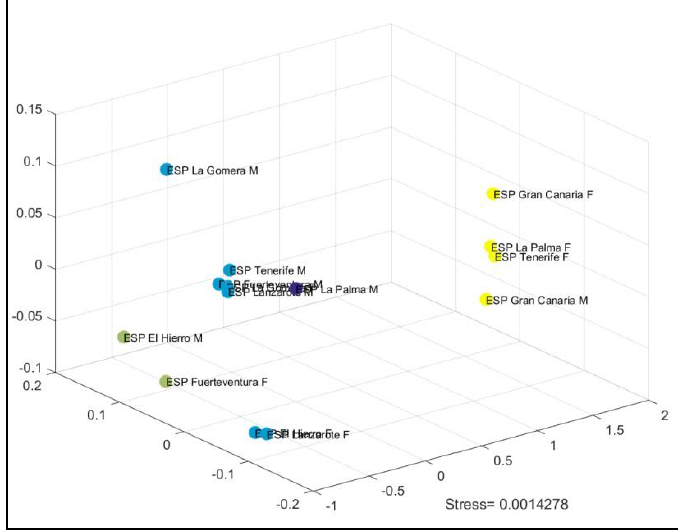
Figure 7. Three-dimensional MDS of SVO + Exp declarative sentences with the value of Stress.